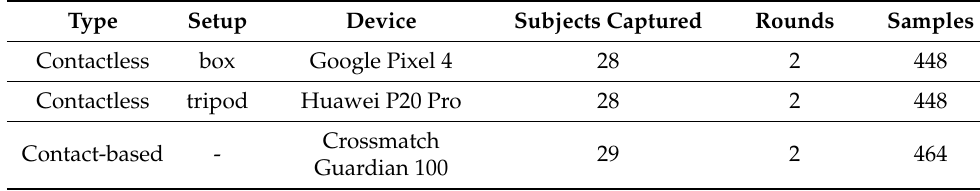
Table 3. Overview of selected recognition workflows with biometric